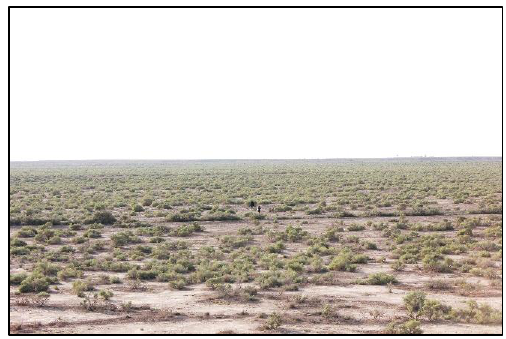
Figure 3. The study area covered by eshnan